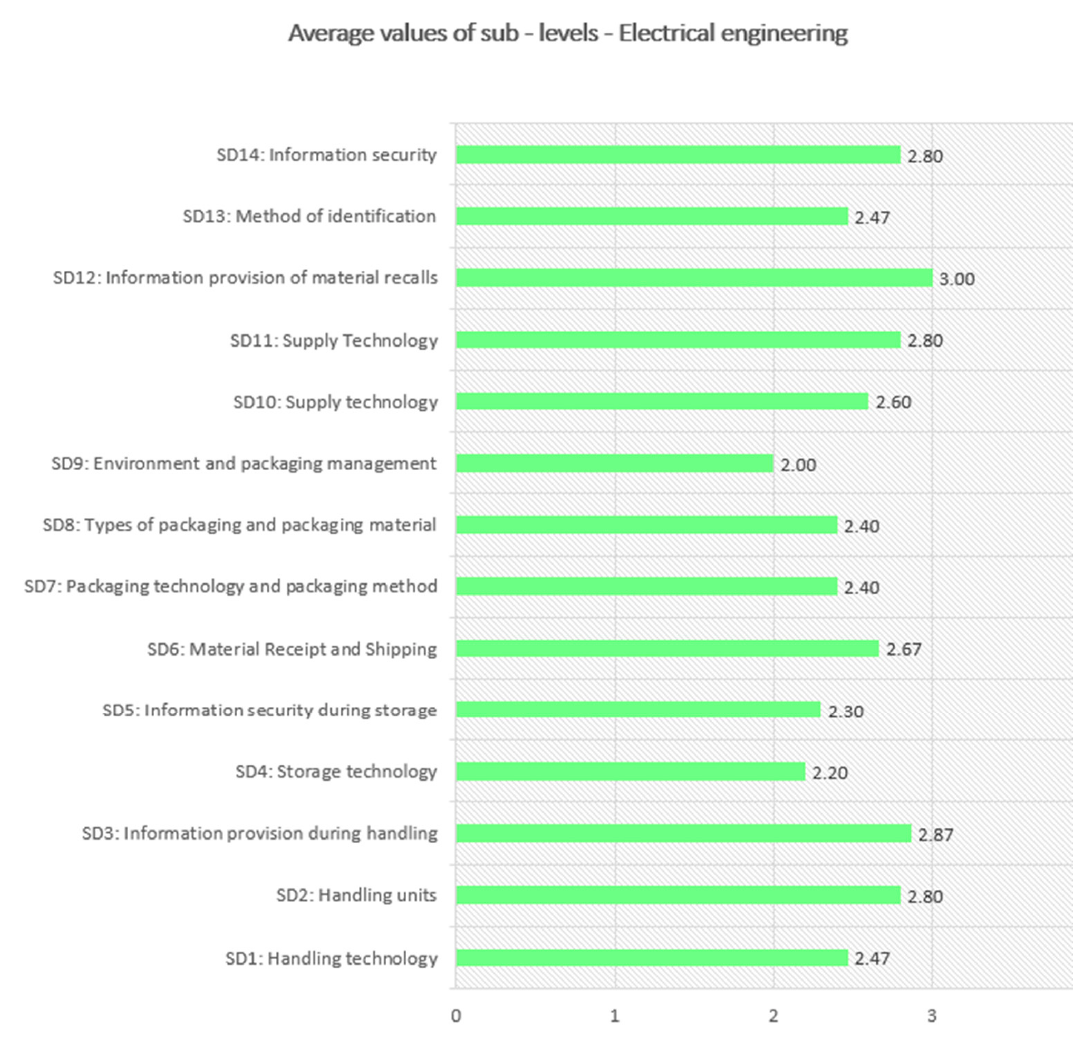
Figure 13. Average values of sublevels—electrical engineering.